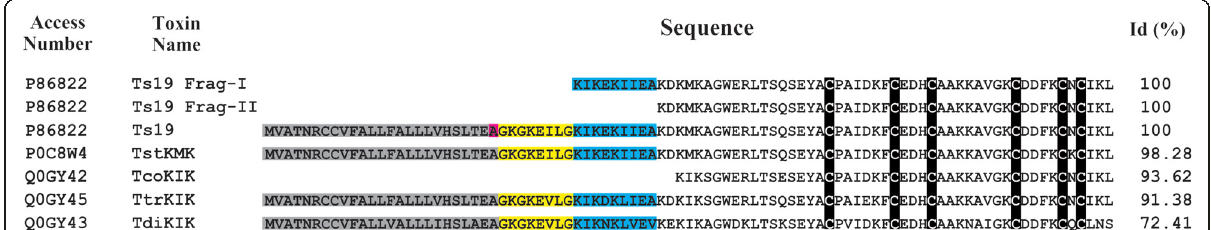
Fig. 5 Ts19 Frag-I alignment. The multiple sequence alignment of Ts19 Frag-I with other β -KTx class (subfamily) 2 scorpion toxins: the amino acid sequences are highlighted according to the residues responsible for signal peptide (gray), propeptide (yellow) and cytolytic effect (blue). The amino acid in pink is considered the N-terminal residue of the toxin by Alvarenga et al . [34]. The alignments and identity – Id (%) were performed using ClustalW2. Cysteines are highlighted in black